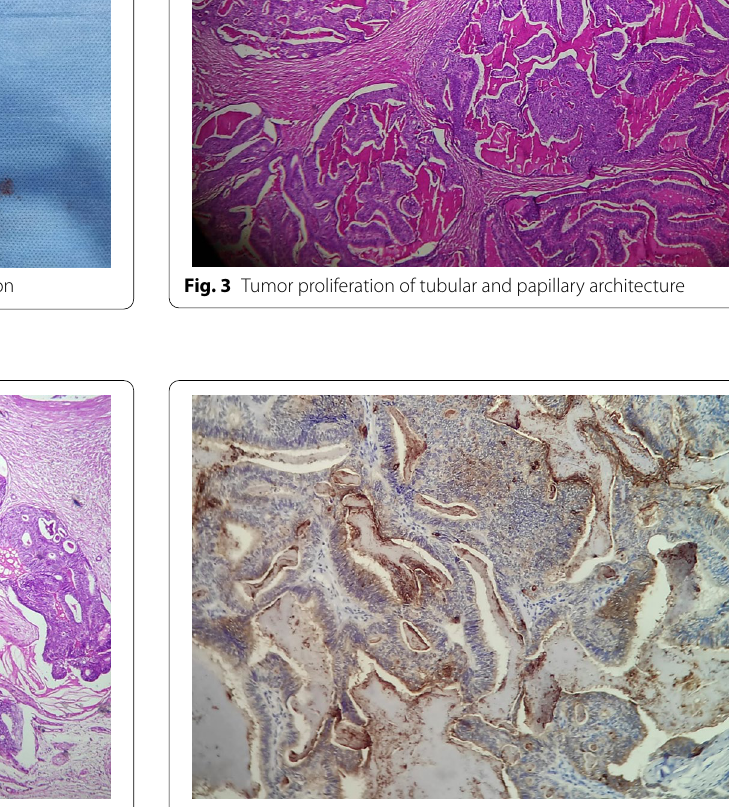
Fig. 2 Testicular parenchyma with cribriform tumor clusters